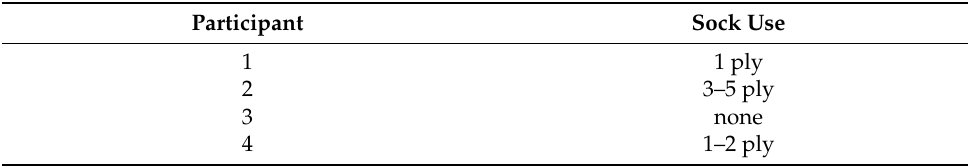
Table 2. Participant sock use during take-home testing.